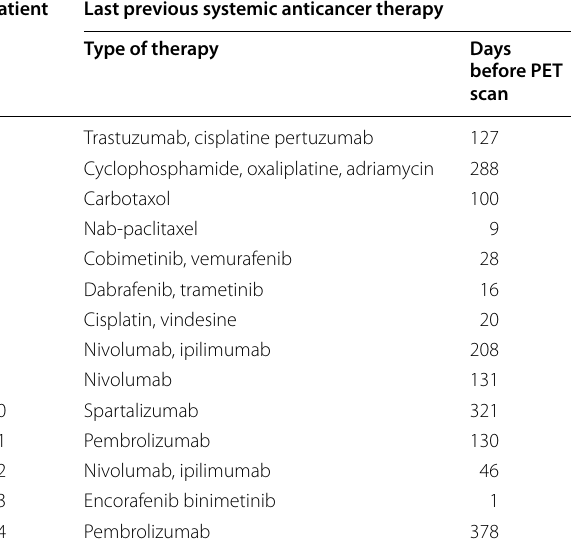
Table 1 Patient characteristics Table 2 Description of the last previous systemic anticancer therapy and the time interval between the last systemic anticancer therapy and the PET scan for each of the 14 concerned